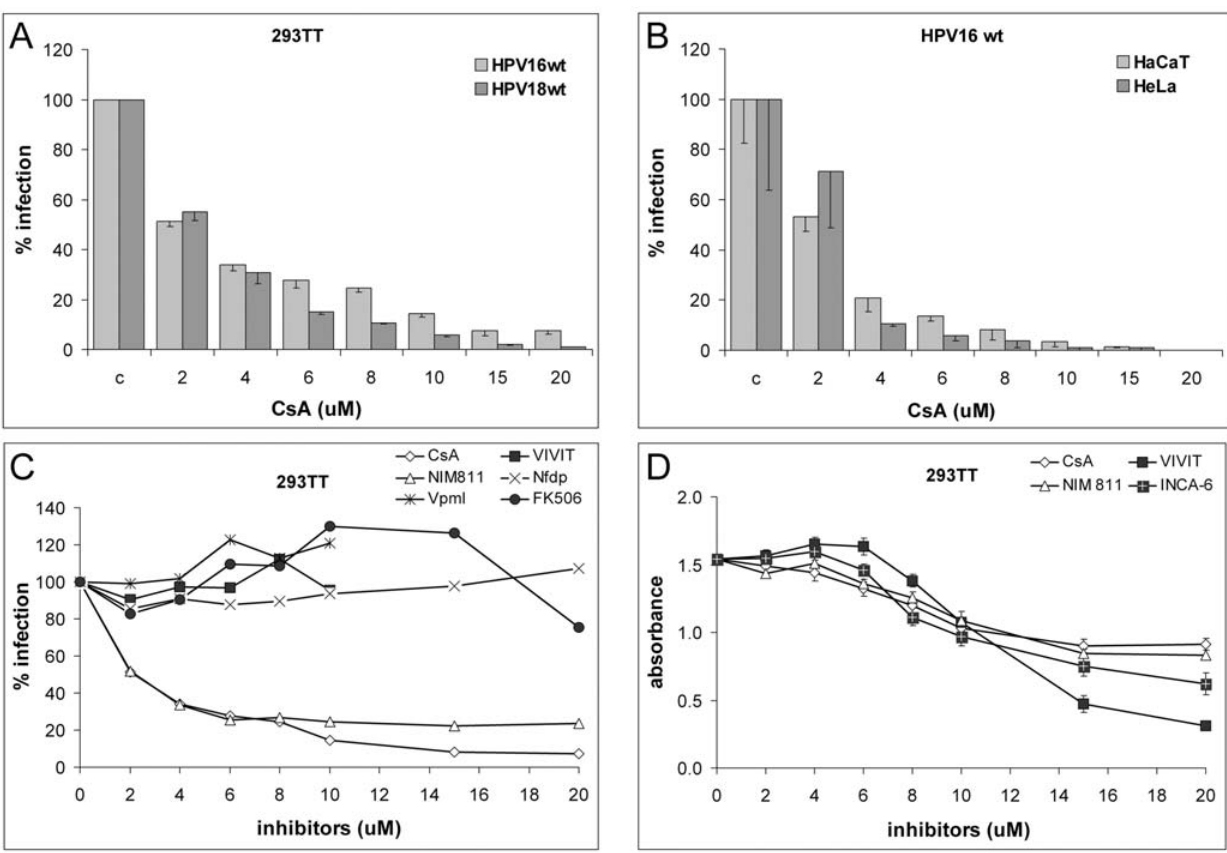
Figure 1. CyP facilitate HPV infection. 293TT (A), HaCaT (B), or HeLa cells (B) were infected with HPV16 (A,B,C) or HPV18 pseudovirus (B) in presence of indicated inhibitors and infection was scored at 72 hpi. (D) Effect of drugs on cell growth was determined by the MTT assay. We did not notice significant increase in cell death. CsA: cyclosporine A; VIVIT: cell permeable 11R-VIVIT; Nfdp: nifedipin; Vpml: verapamil. Representative graphs are based on three replicates each with standard deviation